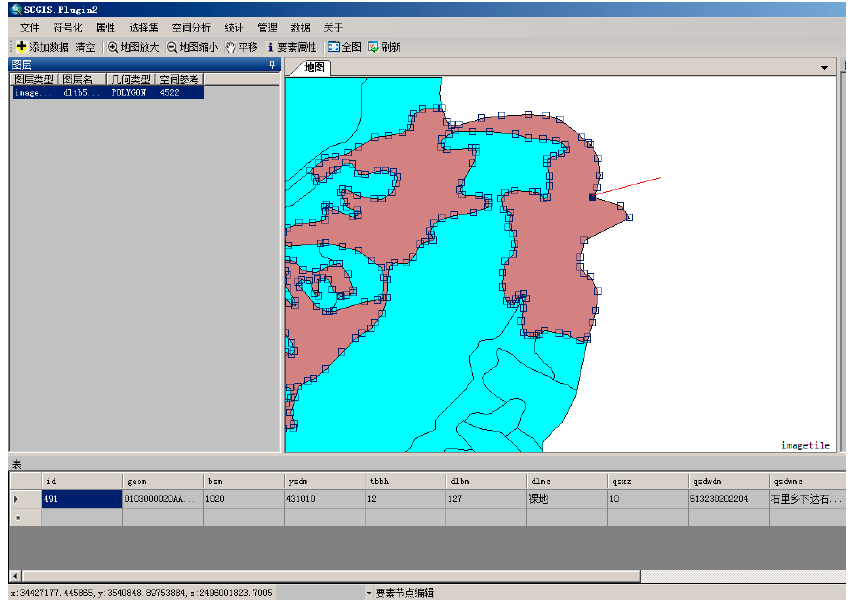
Figure 7. Selection of set interaction and node editing of cluster data. By integrating various GIS open-source libraries, we can further complete more GIS functions on the desktop side in the storage and computing capabilities of spatial data clusters.